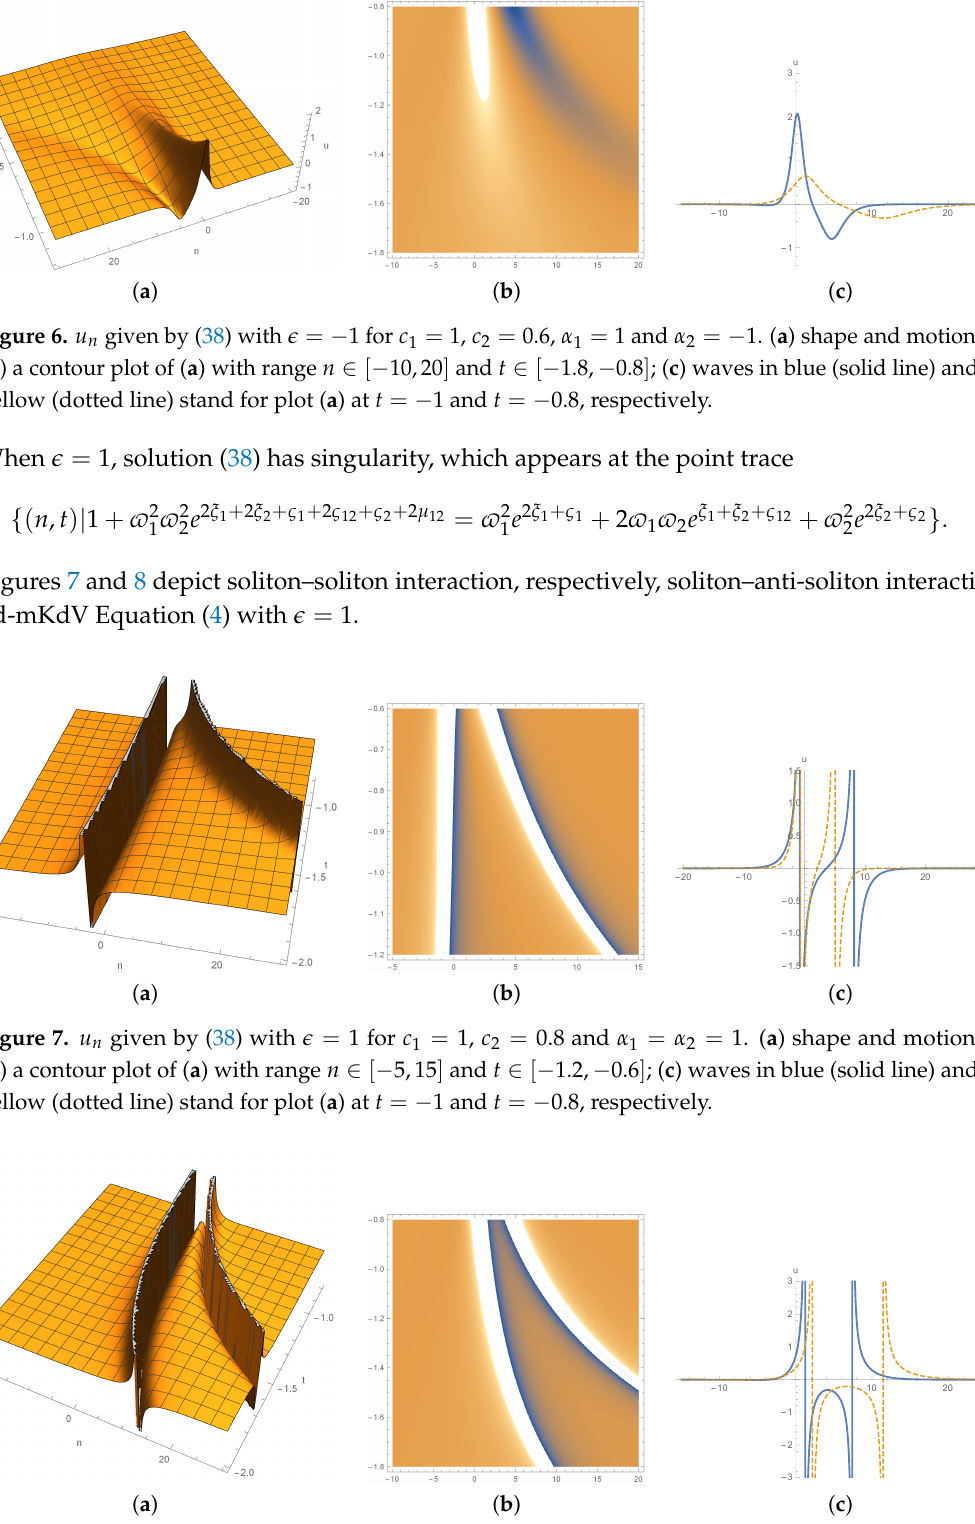
Figure 8. u n given by (38) with (cid:101) = 1 for c 1 = 1, c 2 = 0.8, α 1 = 1 and α 2 = − 1. ( a ) shape and motion; ( b ) a contour plot of ( a ) with range n ∈ [ − 10,20 ] and t ∈ [ − 1.8, − 0.8 ] ; ( c ) waves in blue (solid line) and yellow (dotted line) stand for plot ( a ) at t = − 1 and t = − 1.2,